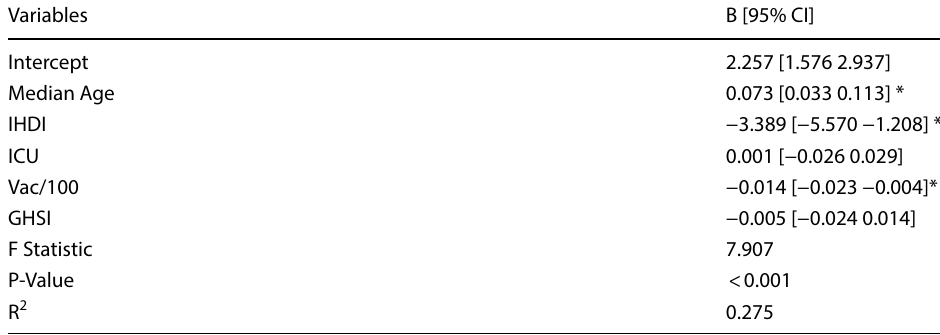
Table 3 Final regression model for Covid-19 Case Fatality Rate